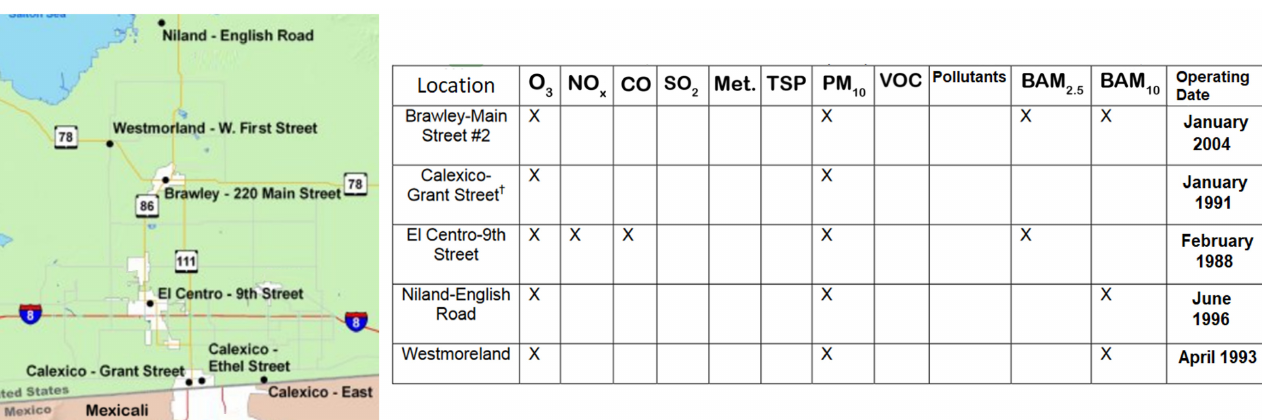
Figure 4. Geographical location of the air monitoring stations in the Imperial Valley and contaminants that can be monitored. Source: California Air Resources Board (CARB), Imperial County Air Pollution Control District (ICAPCD), U.S. Environmental Protection Agency (EPA). [x] Indicates that the air monitoring stations have the capability to measure